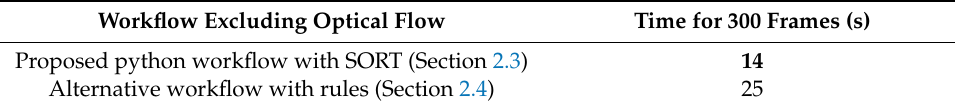
Table 5. Computational time for workflows excluding optical flow. Bold numbers indicate the best performing